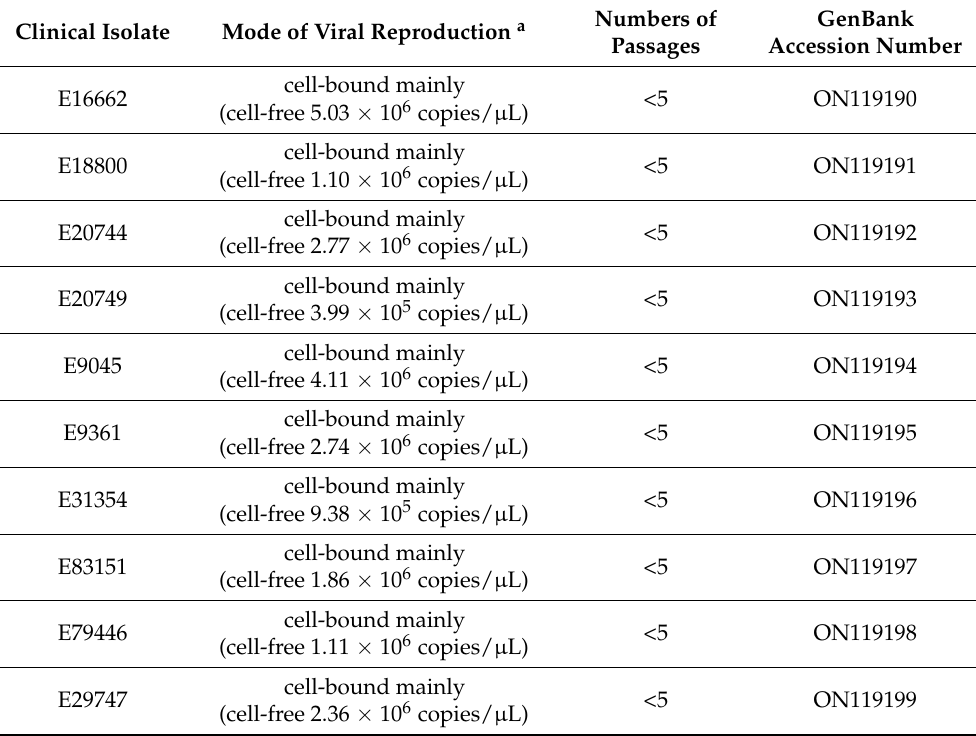
Table 1. Details of HCMV Ulm isolates and ORF-UL97 primary